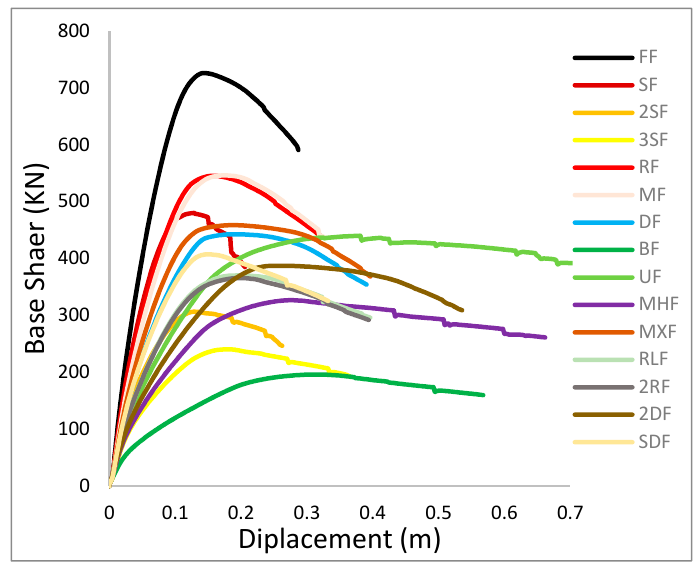
Figure 6. Pushover curves of the models studied.